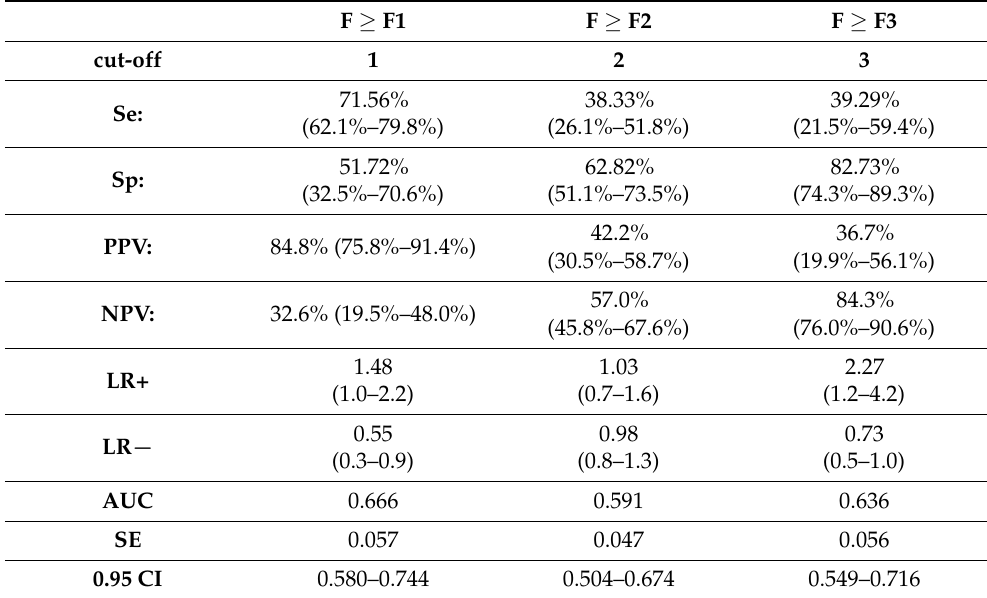
Table 10. The diagnostic performance of BARD for fibrosis grades greater than or equal to 1, greater than or equal to 2, and greater than or equal to